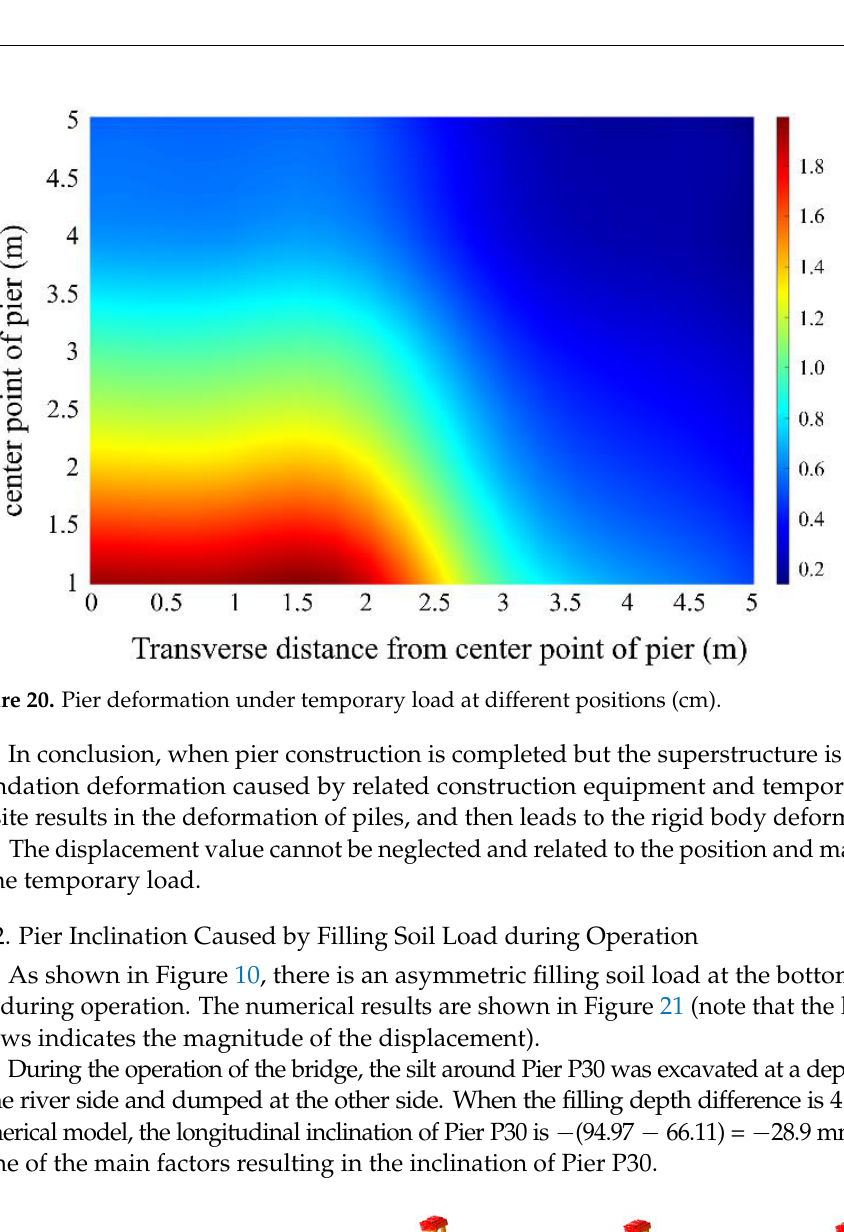
Figure 20. Pier deformation under temporary load at different positions (cm).